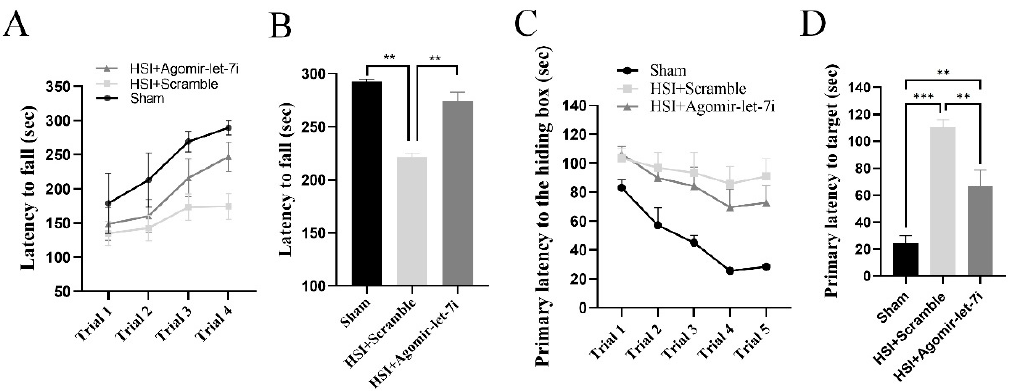
Figure 5. Mice with an HSI exhibit voluntary movement and forepaw grip deficits. ( A ) The averages for latency to fall from an accelerating rotarod across four rotarod test trials for sham mice, scramble-treated, and agomir-let-7i-treated HSI mice. ( B ) Agomir-let-7i-treated animals displayed less impairment on the rotarod after HSI than did the scramble-treated animals at 15 dpi. ( C ) During the training phase of the Barnes maze test, mice in every group showed improved latency of first entrance into the hiding box, but agomir-let-7i-treated HSI mice spent less time locating the hiding box compared with scramble-treated HSI mice. ( D ) In the probe test, HSI mice had a significantly longer latency to locate the hiding box ( B ) compared with their sham controls, but scramble-treated HSI mice spent a longer time reaching the target compared to agomir-let-7i-treated HSI mice. Data are presented as mean ± SEM. n = 8 mice per group. ** p < 0.01, *** p < 0.001.